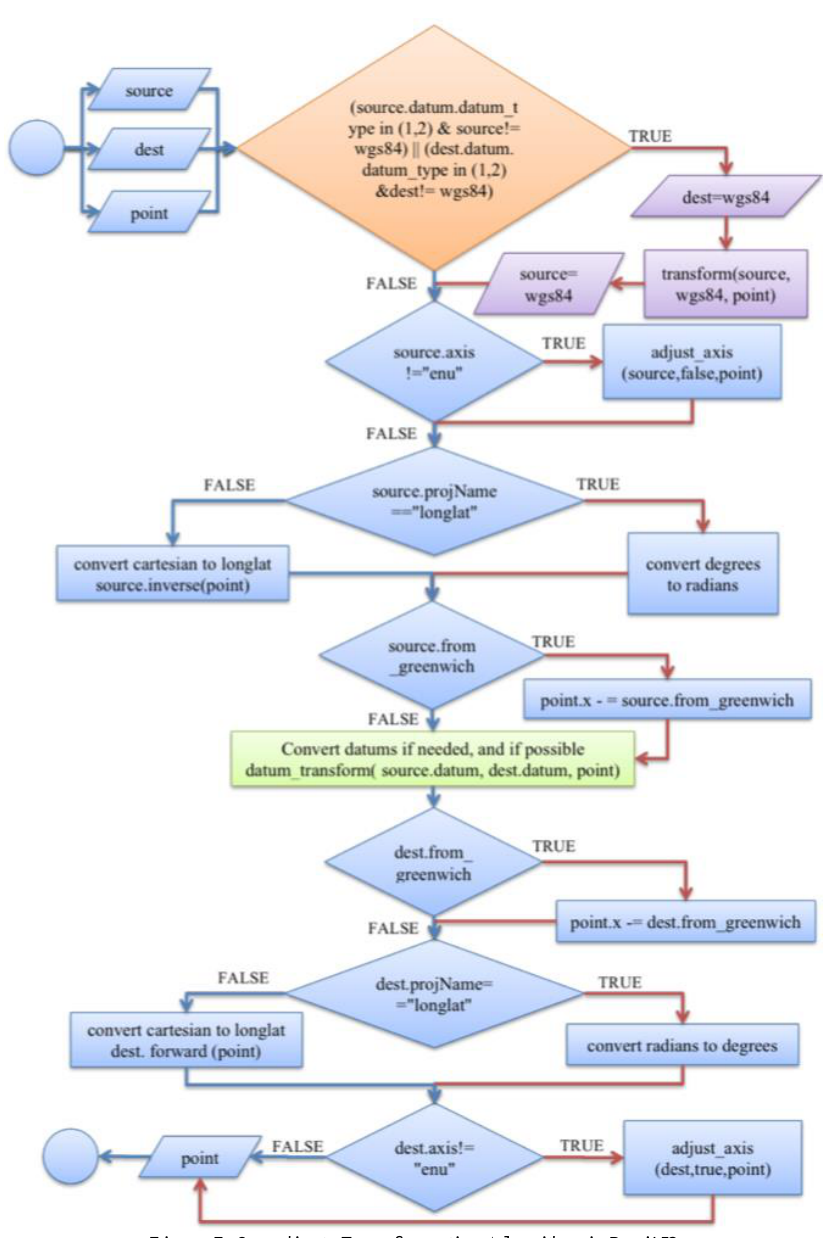
Figure 7. Coordinate Transformation Algorithm in